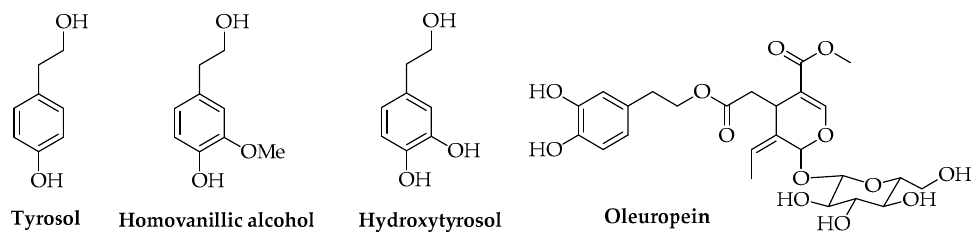
Figure 4. Phenolic compounds found in Olea europaea L.